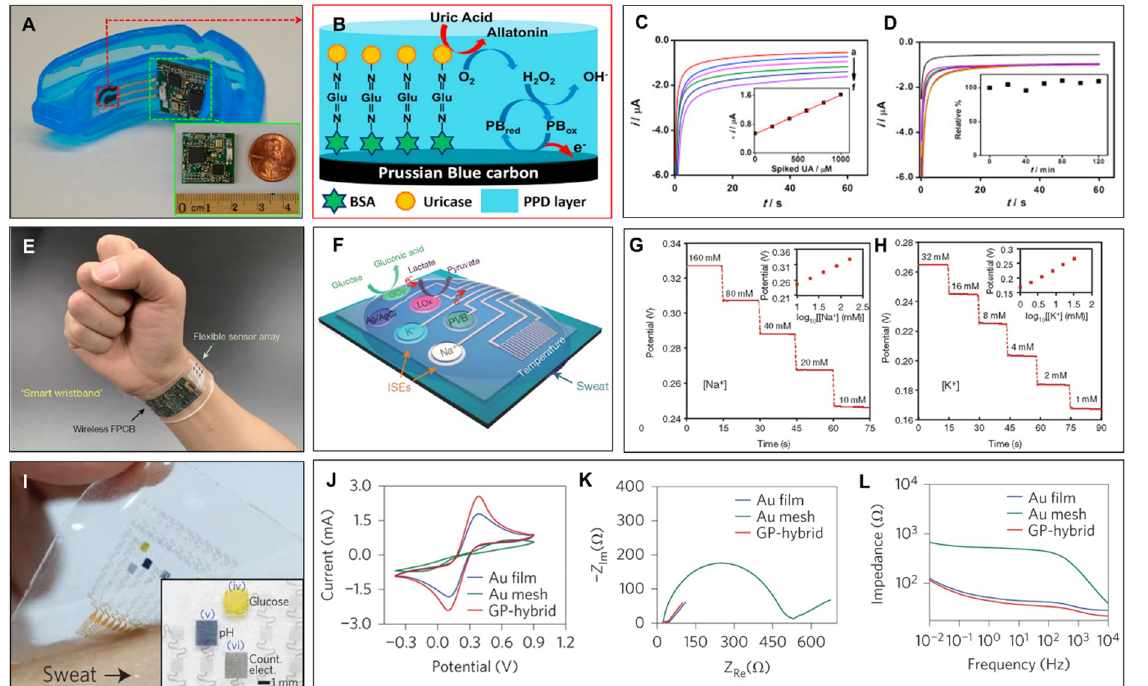
Figure 3. Wearables using amperometric, potentiometric, impedimetric, and voltammetric transducer mechanisms. ( A ) Kim et al.’s smart mouthguard with integrated working electrodes and PCB module with Bluetooth for wireless data communication [67]. ( B ) Schematic illustration of the reported bio-receptor yielding amperometric changes due to binding of salivary uric acid to uricase containing working electrode. ( C ) Recorded amperometric changes with the increasing concentrations steps of 0.2 mM ( A – F ). Inset shows the resulting calibration plot with respect to uric acid concentration. ( D ) Stability of measurements with respect to time. Authors have reported the stability of the amperometric transducers with 20 min. intervals over a total 2 h measurement. Inset shows the deviations from the original amperometric response at t = 0. ( E ) Gao et al.’s wearable-integrated sensor array allows real-time sweat analysis [68]. ( F ) Schematic representation of the array of sensors including potentiometric transducing of sodium (Na + ) and potassium (K + ) ions, and amperometric transducing of glucose and lactate from sweat. A resistance-based temperature sensor is also